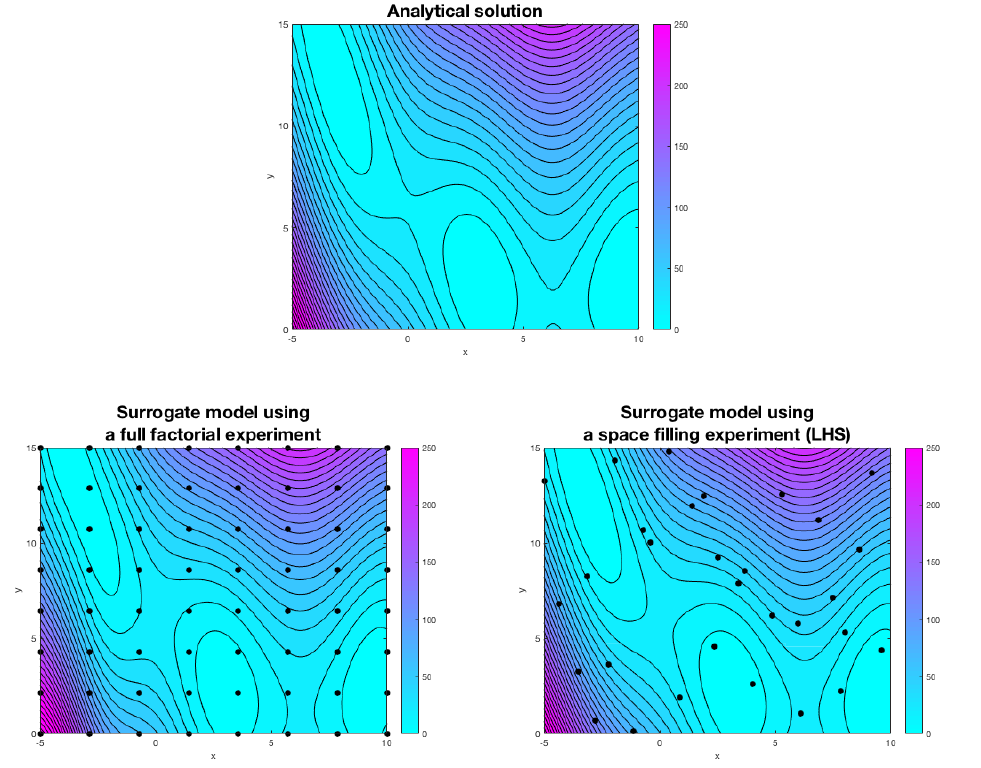
Figure 4. Top: analytical solution. Bottom-left: surrogate model using a full-factorial experiment with 64 training points. Bottom-right: surrogate model using a space-filling experiment with 30 training points (Latin hypercube sampling,